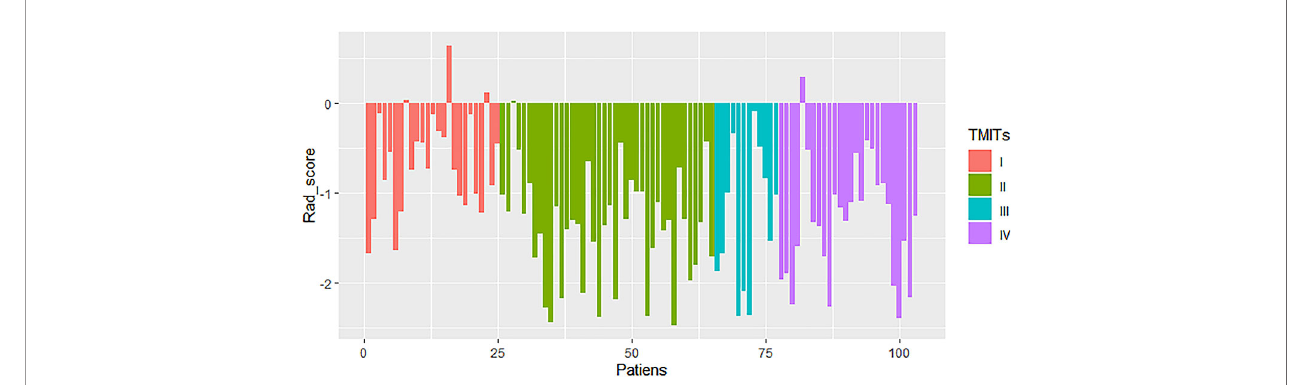
FIGURE 3 | Rad-score of patients in the cohort of patients with non-small cell lung cancer (NSCLC). Generally, rad-scores in the tumor microenvironment immune type (TMIT)-I tumors were higher than